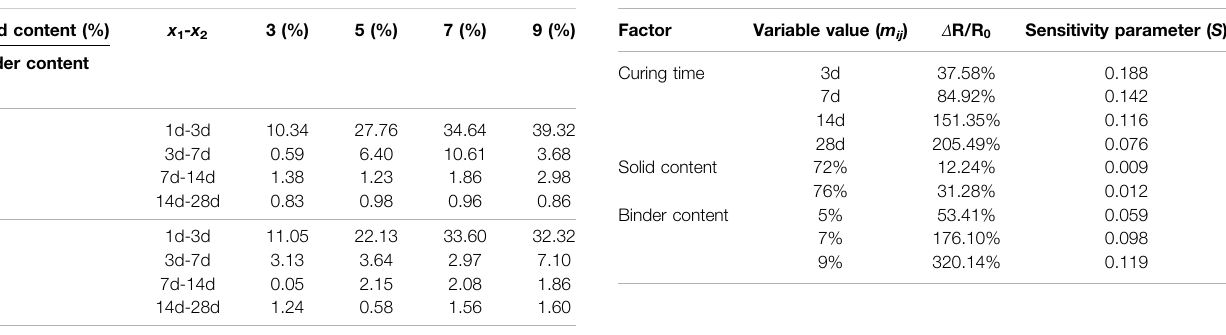
TABLE 3 | The growth rate of UCS with curing time. TABLE 4 | Sensitivity parameter values of